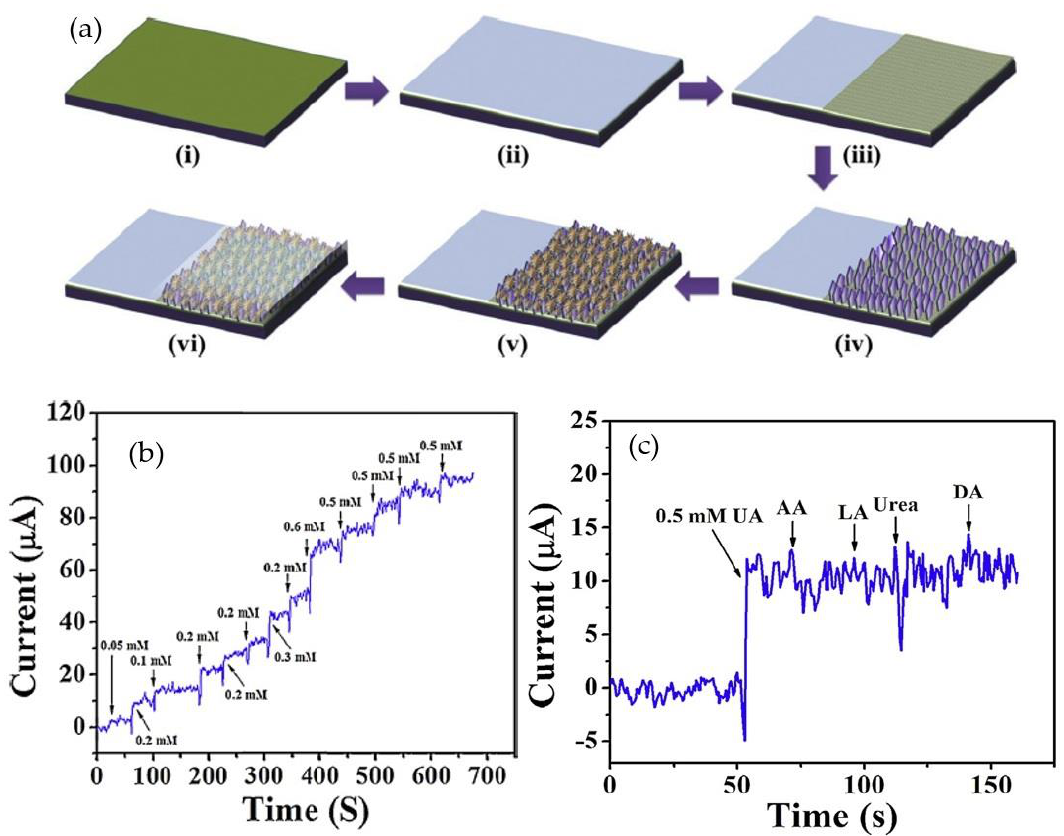
Figure 15. ( a ) Illustration of the fabrication process for a uric acid biosensor; ( b ) amperometric response of the biosensor toward urid acid; and ( c ) interference test of the uric acid biosensor upon addition of electroactive species. Reprinted from Ref. [127]. Copyright 2015, with permission from Elsevier.